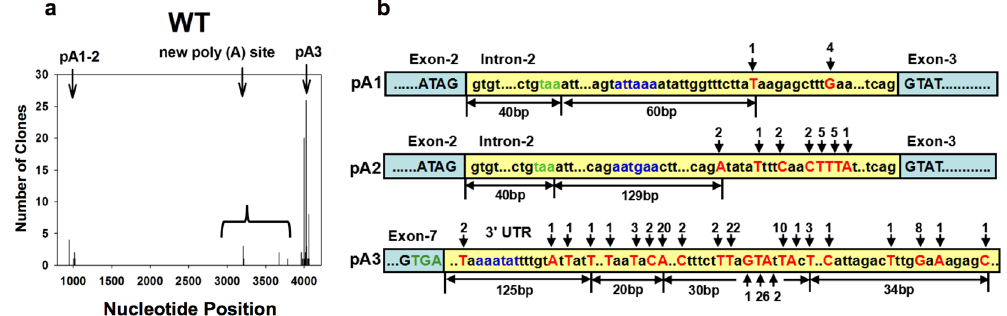
Figure 2. Poly(A) sites and Poly(A) signals of OXT6 in wild type plants detected by 3 ′ RACE. ( a ) Poly(A) sites detected by 3 ′ RACE performed with wild type plants. Nucleotide position of OXT6 gene (start from ATG) is listed at X-axis, and number of clones polyadenylated at the specific nucleotide is marked by vertical bars at Y-axis. ( b ) Illustrations of poly(A) sites and presumed NUE signals of pA1, pA2 and pA3 in wild type plants. Poly(A) sites [the last nucleotide before the poly(A) tail] are indicated in red; NUEs are indicated in blue; and stop codons are in green. Number of clones sequenced for each poly(A) site is labeled above or below the arrow. Intron-2 and 3 ′ UTR are shaded in yellow while exons are shaded in blue. Dots ( … ) represent omitted nucleotide sequences (not drawn in scale).